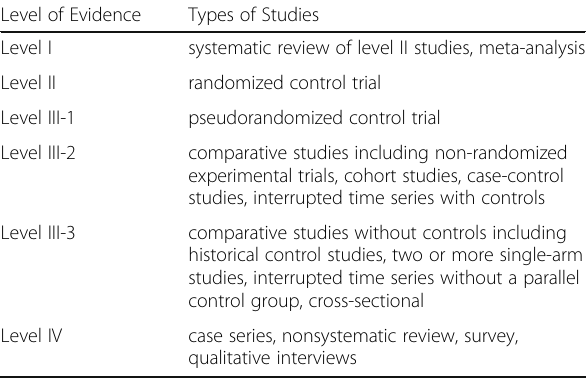
Table 2 Types of Studies by Evidence Level